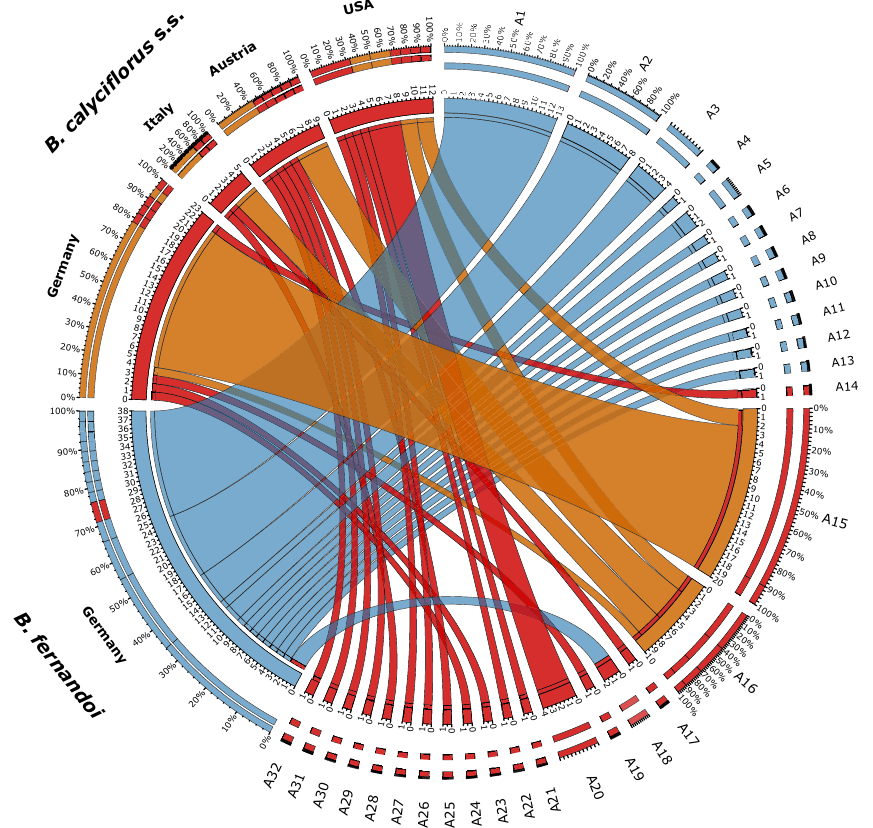
Figure 3. HSP 40 kDa allele identification. Circos plot of allele distribution among species B. calyciflorus s.s. and B. fernandoi and country of sample origin (Germany, Italy, Austria, USA). Labels A1-A32 stand for the identified alleles, red alleles are derived from B. calyciflorus s.s. and blue alleles from B. fernandoi . B. calyciflorus s.s. alleles found in more than one location are coloured